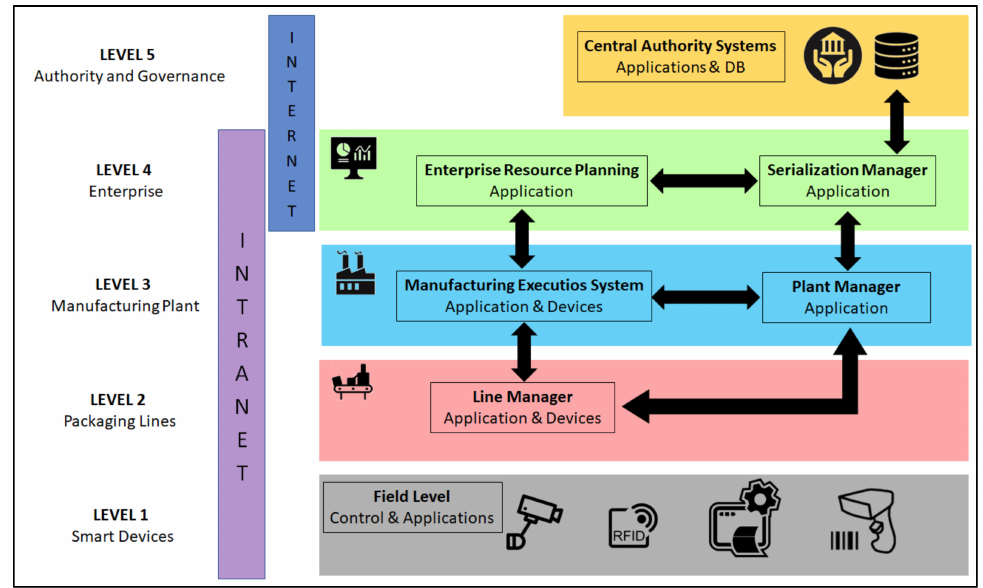
Figure 4. Architecture of the information system for the serialization